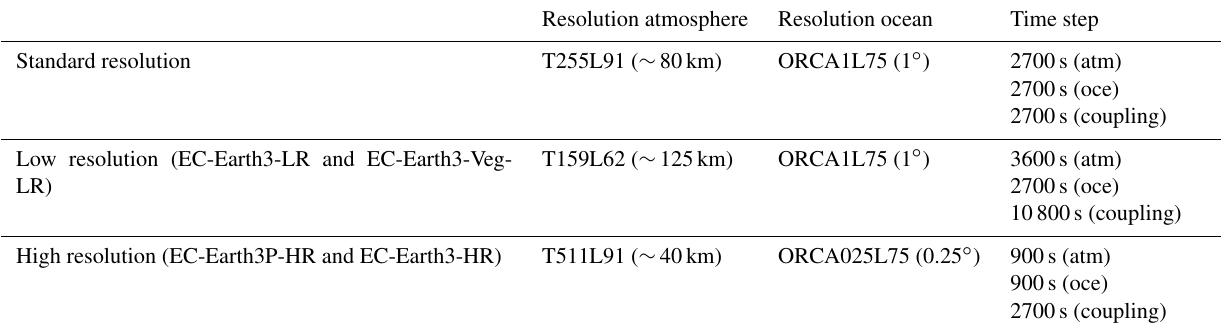
Table 2. Commonly used resolutions for CMIP6. The suffixes LR and HR are added to the name of the model configuration where applicable (e.g.,